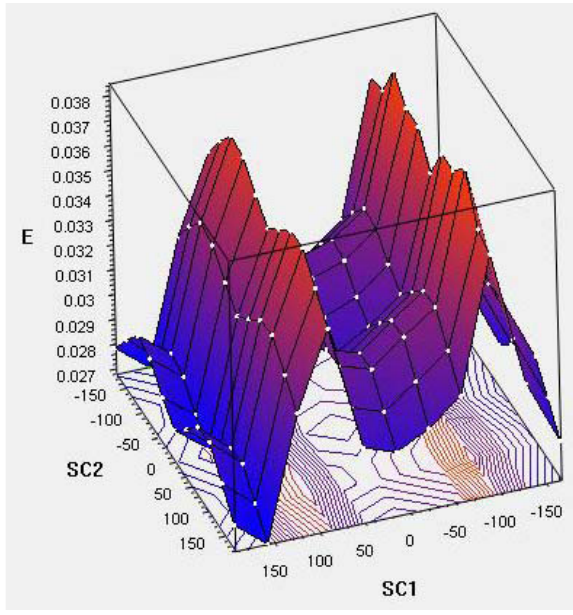
Figure 2: The potential energy scan of the MIMIM